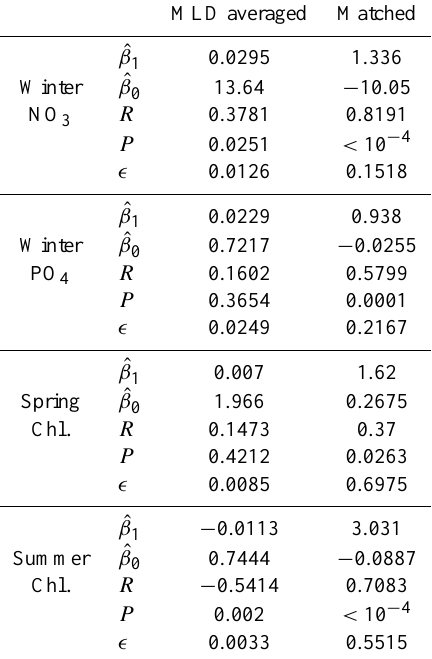
Table 7. Linear regression output parameters for nitrates (NO 3 ), phosphates (PO 4 ) and chlorophyll (Chl.). The parameters shown are the slope of the line ( ˆ β 1 ), the y-axis intersect ( ˆ β 0 ), the correlation coefficient ( R ), and the two-tailed probability ( P ), the standard er- ror ( (cid:15) ), and the number of data ( N ).